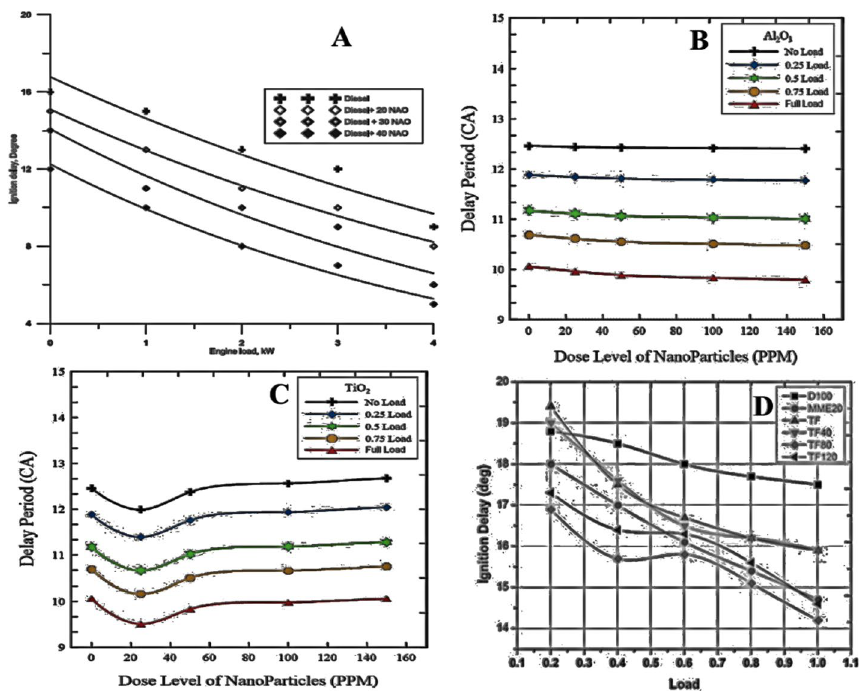
Fig. 11 Effect of Ignition delay of nano-added diesel or